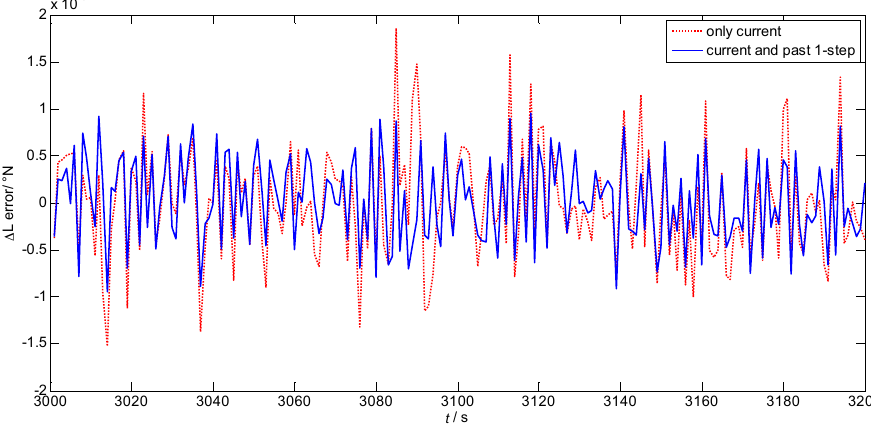
Table 1. Prediction errors of different steps.